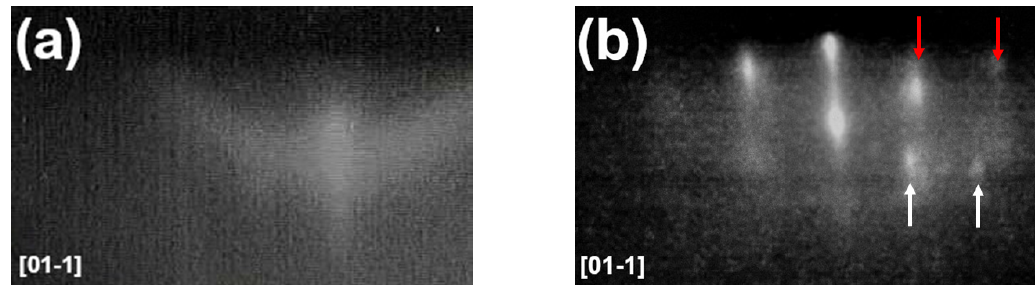
Figure 3. Reflection of high energy electron diffraction (RHEED) patterns of 2 ML In deposited on vicinal GaAs(111)A with 2 ◦ miscut towards ( 112 ) at ( a ) 185 ◦ C (halo pattern) and at ( b ) 80 ◦ C (spotty pattern). Red arrows indicate RHEED reflexes from indium crystalline islands and white arrows indicate RHEED reflexes from